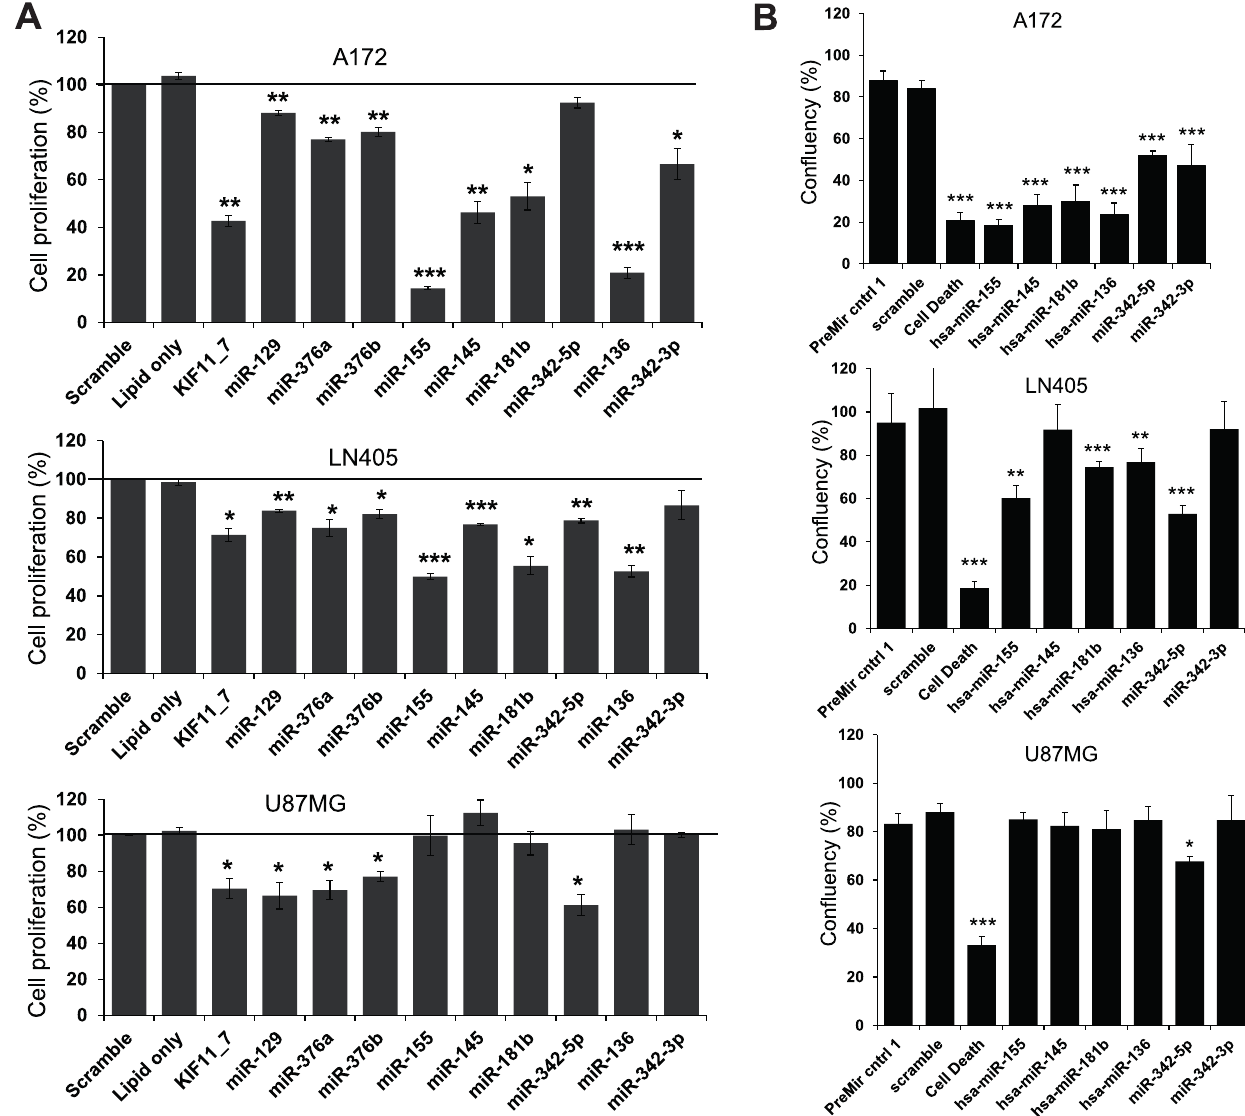
Figure 2. Validation of hit precursor miRNAs that reduced proliferation with A) CellTiter-Glo assay at 72 h after transfection (n=3 biological, 4 technical repeats), B) monitoring cell growth and confluence by taking time-lapse phase contrast images with an IncuCytePlus microscope at 95 h after transfection (n=3). Values are mean + / 2 s.e.m.; statistically significant changes are shown with asterisks (*p , 0.05, **p , 0.01, ***p ,